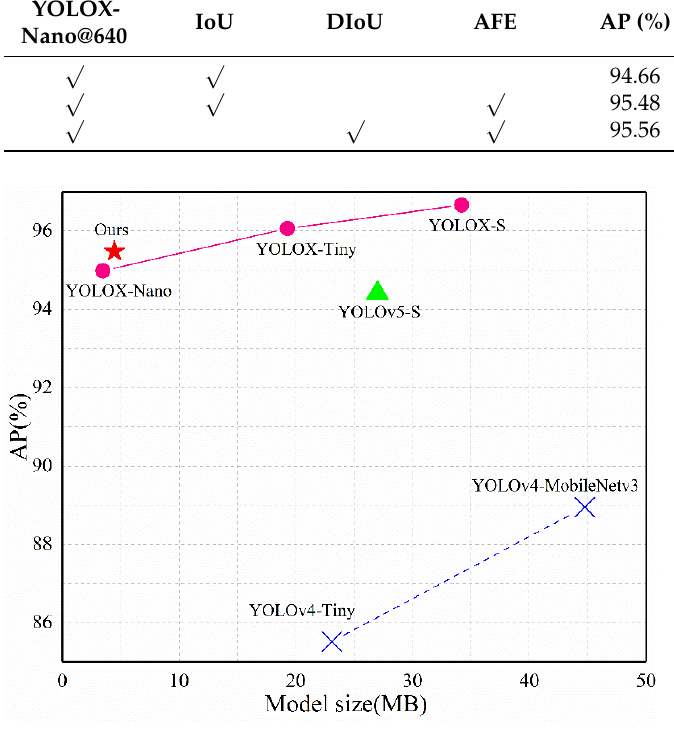
Figure 11. Size-accuracy curve for our method and other state-of-the-art object detectors.